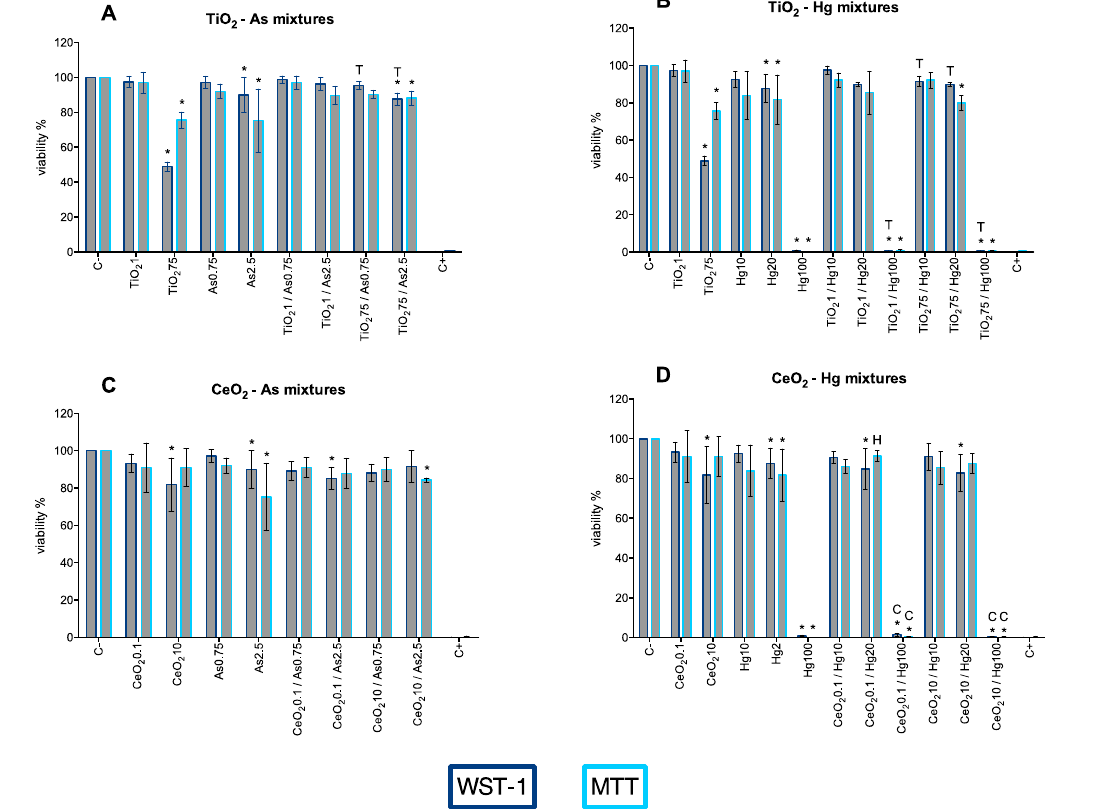
Figure 8. Viability of A549 cells 24 h post ‐ exposure to binary mixtures of NP and metals ‐ TiO 2 NP ‐ As ( A ), TiO 2 NP ‐ Hg ( B ), CeO 2 NP ‐ As ( C ), CeO 2 NP ‐ Hg ( D ), assessed by WST ‐ 1 (dark blue bars) and MTT (light blue bars) assays, compared to single exposure (left bars). All concentrations expressed in mg/L with the exception of CeO 2 NP which is expressed in μ g/L. C − : negative control; C+: positive control (Triton X ‐ 100 1%). Values are expressed as mean ± standard deviation (n ≥ 3, each experiment in triplicate). Statistical significance of samples compared to C − is indicated by *; also indicated is statistical difference compared to NP (Titanium T; Cerium C) and/or metal (Arsenic A; Mercury H) (One ‐ way ANOVA; p ≤ 0.05).